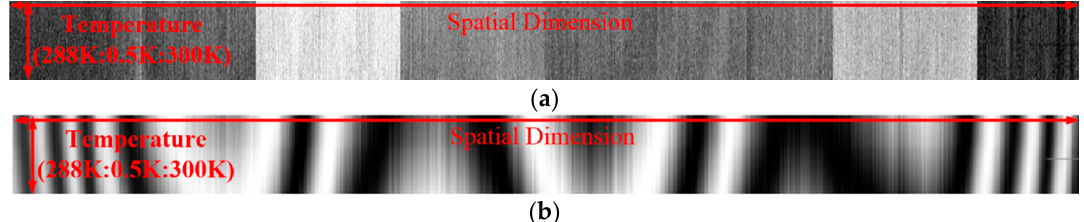
Figure 13. A sequential series of flat-field frames (150 bands by 2048 columns) were collected with the increasing of the CCD operating temperature, then the sequential series of ( a ) band 75 and ( b ) band 120 from each frame are presented with the increasing of the CCD operating temperature.